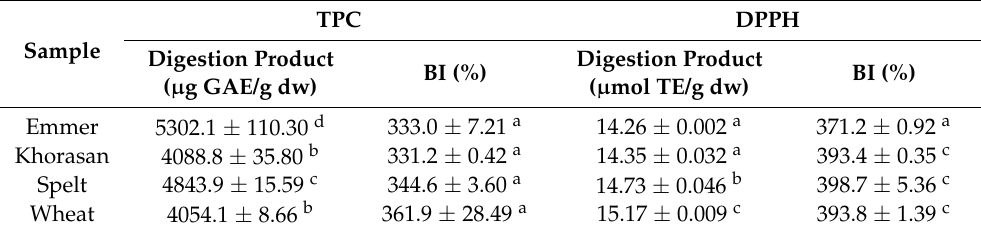
Table 4. Total phenolic content (TPC) and DPPH antioxidant capacity after simulated bread in vitro digestion and bioaccessibility indexes